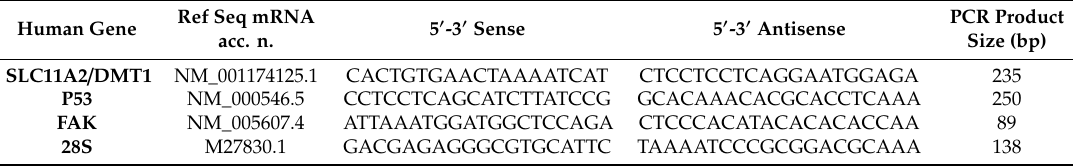
Table 1. Details of primer sequences for the qPCR assays. For each gene, the NCBI accession number of the mRNA reference sequence (Ref Seq mRNA; rDNA for the 28S ribosomal gene) used for primer design is reported. Gene-specific nucleotide sequences are reported as forward (sense) and reverse (antisense) primers on the 5 (cid:48) -3 (cid:48) direction. For each primer pair, the expected amplicon length is reported (PCR product size) as base pairs (bp). Human genes are listed with the o ffi cial symbols / aliases. Ref Seq mRNA Human Gene acc.